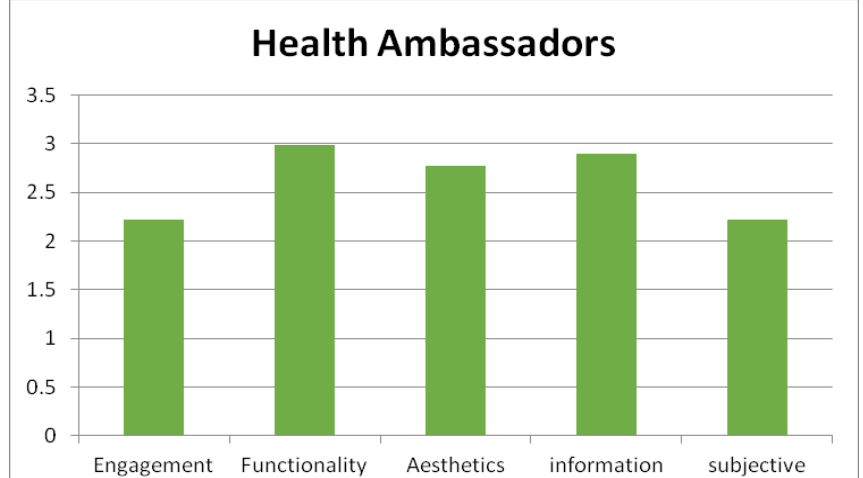
Fig 5. The evaluation of indicators in Health Ambassadors according to MARS